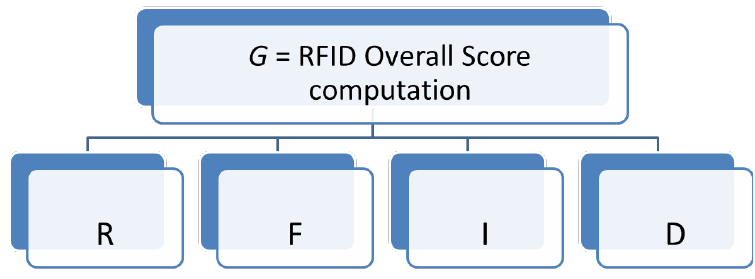
Figure 5. AHP Figure 5. AHP Hierarchy.